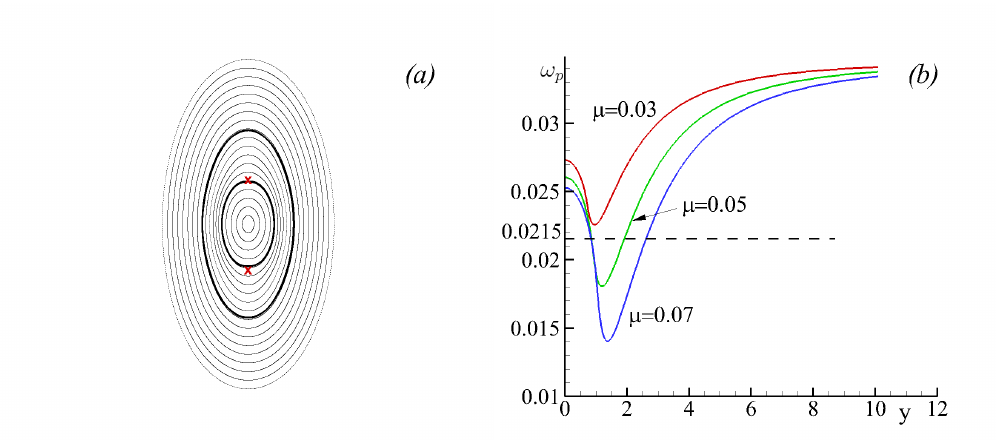
Figure 25. ( a ) A stationary phase portrait of the advection system in Equation (62) with two singular vortices of weak strengths µ 1 = µ 2 = 0.05 that are located in the lower layer: Ω 0 = − 0.02 and S 0 = − 0.01. ( b ) Fluid particle rotational frequency corresponding to the phase portrait for different vortex strengths.